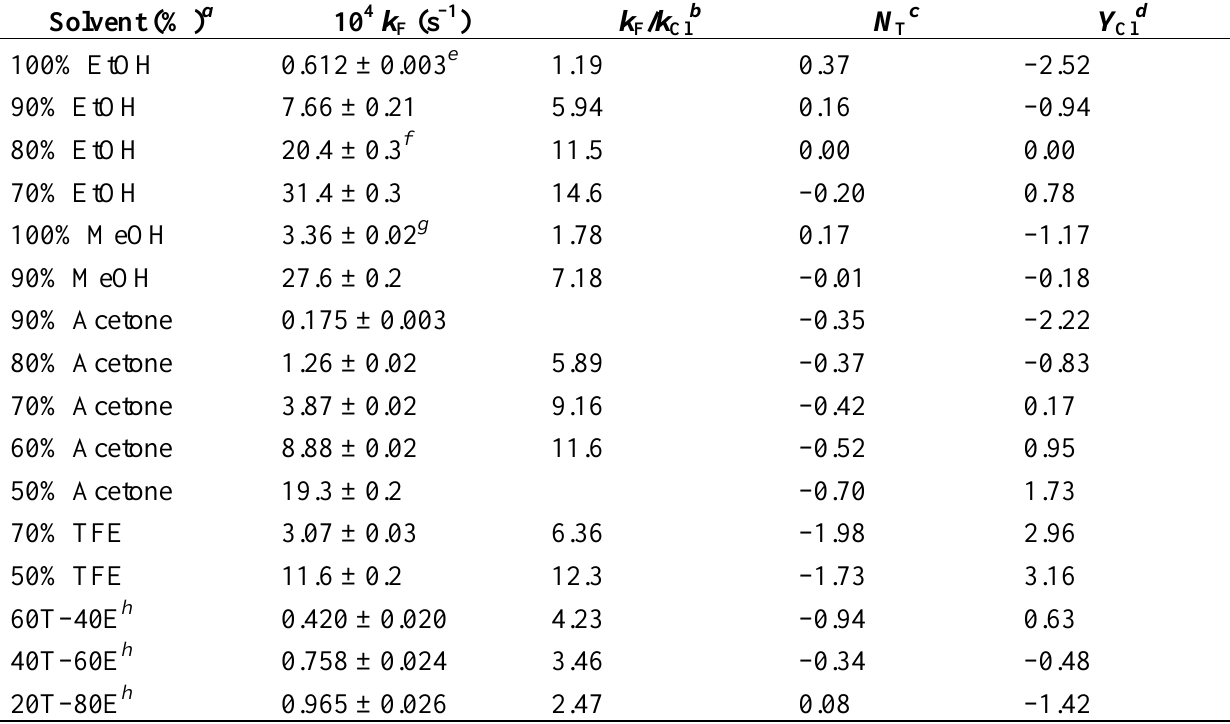
) for the solvolysis of benzyl fluoroformate in pure and binary F ) and solvent ionizing T power ( Y ) values and k / k Cl F Cl